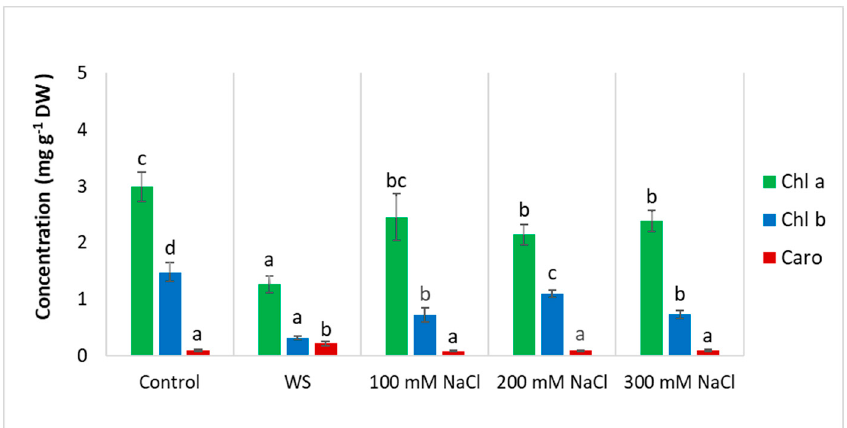
Figure 2. Photosynthetic pigments levels under water and salt stress. Needle concentrations of chlorophyll a (Chl a), chlorophyll b (Chl b) and total carotenoids (Caro) in one-year-old A. alba seedlings after 30 days of growth in the presence of the indicated salt concentrations or subjected to water deficit (completely withholding irrigation) (WS). Bars represent means ± SE ( n = 7). For each of the three pigments, different letters above the bars indicate significant differences between treatments, according to Tukey’s test ( α = 0.05).